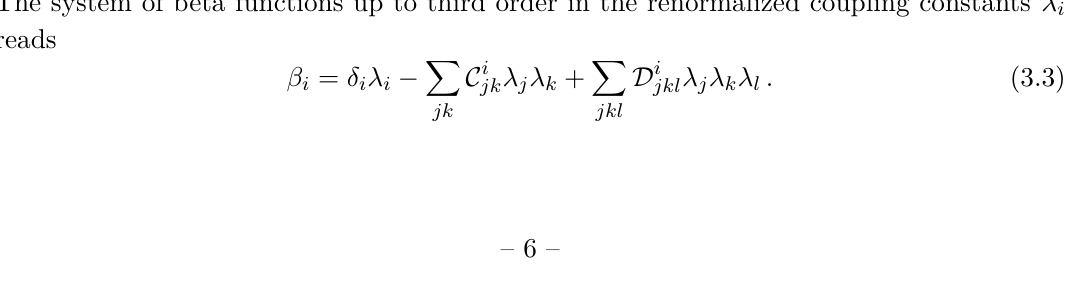
looks like on K